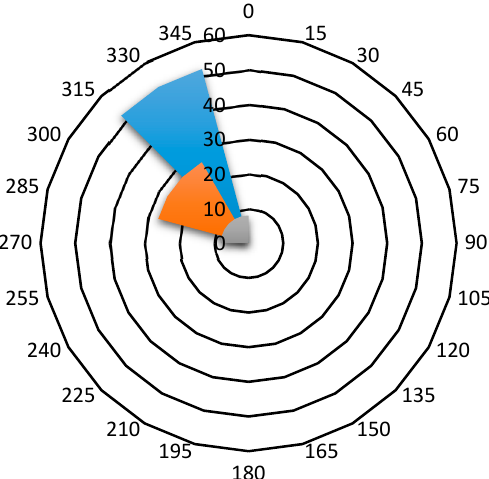
Figure 12. Wind rose diagram for the Ras Ghareb zone at a 24.5 m height.